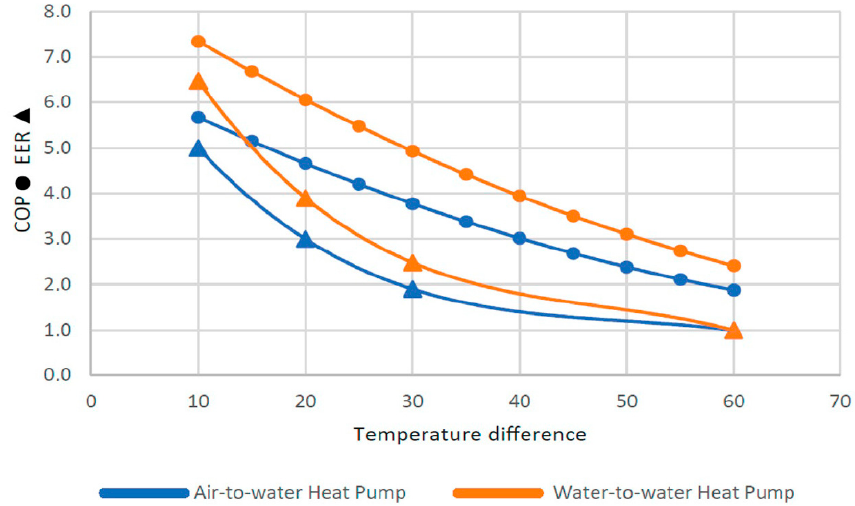
Figure 1. COP and EER reference trends as a function of temperature difference between sources.